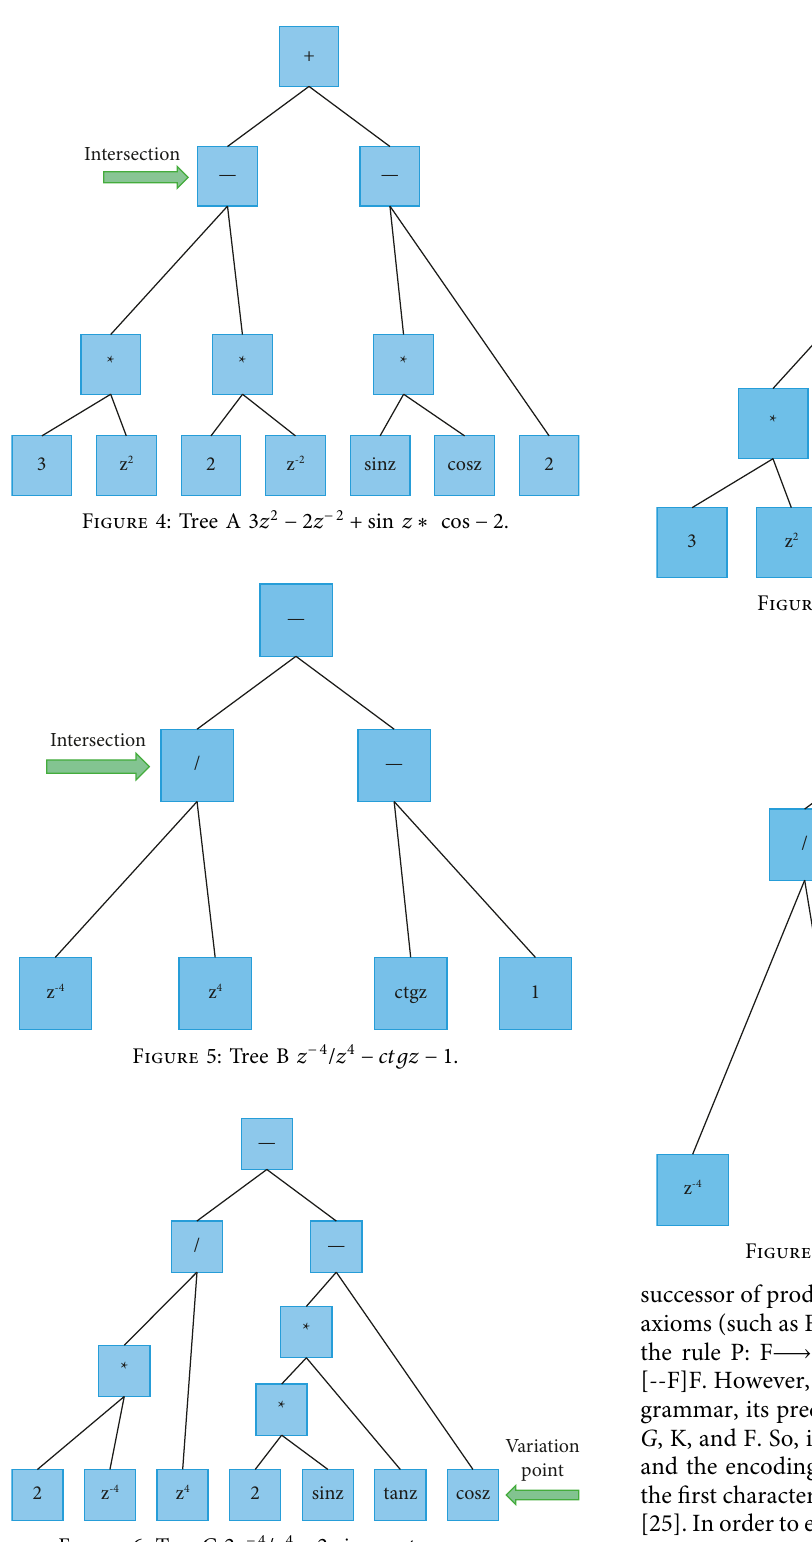
Figure 6: Tree C 2 z − 4 / z 4 − 2 sin z ∗ tan z − cos z .